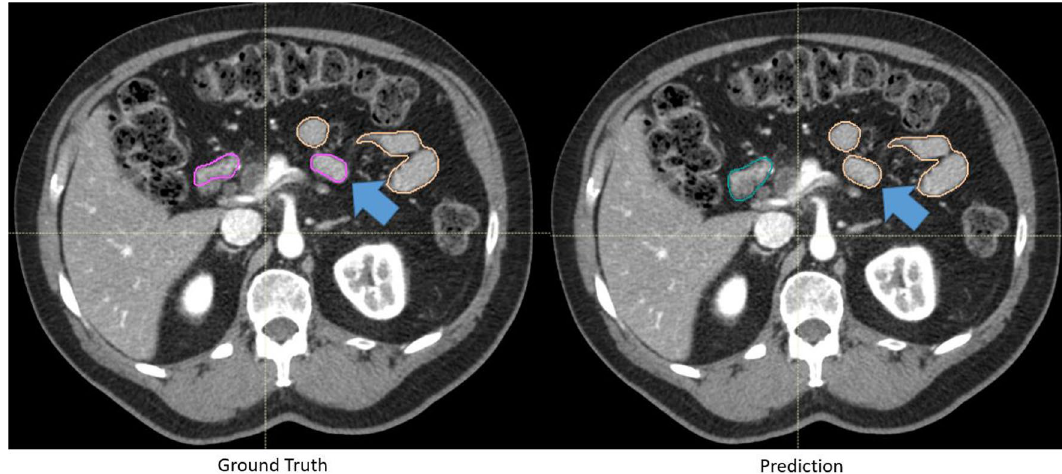
Figure 6. Representative ground truth (left) and the automatically generated (right) contours of a patient’s duodenum and small bowel (jejunum). The ground truth is ambiguous at the transition from duodenum to small bowel (jejunum). The deviation from the ground truth was deemed as a stylistic difference.